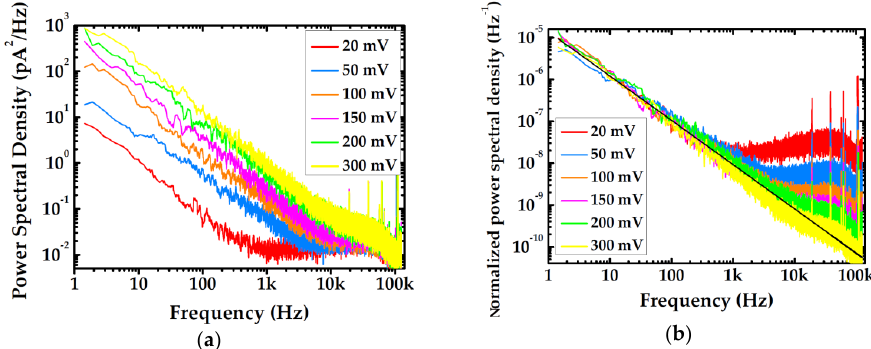
Figure 2. Noise traces of a graphene nanopore with diameter of 5 nm at 100 mM KCl: ( a ) Noise power spectral density at varied bias voltage; and ( b ) normalized noise power spectral densities. The black straight line represents the average result of the low-frequency linear fitting.